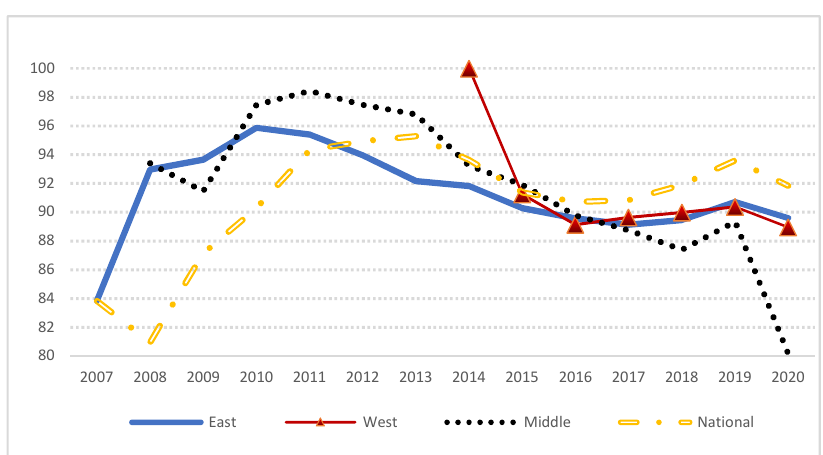
Figure 5. Operating efficiencies of the different types of commercial banks.